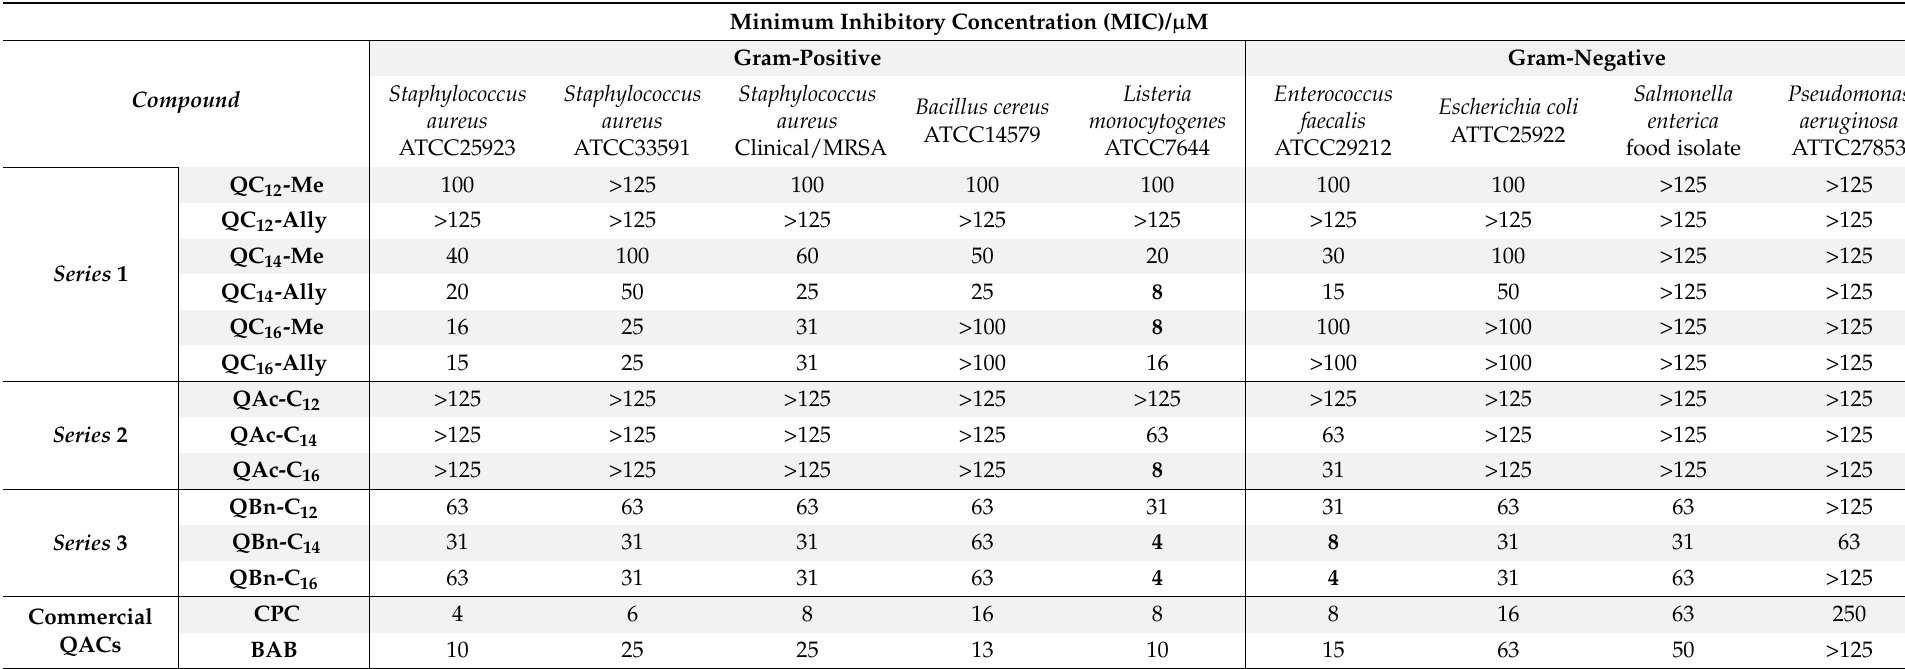
Table 1. Minimal inhibitory concentrations (MICs) of 3-amidoquinuclidine quaternary ammonium compounds in µ